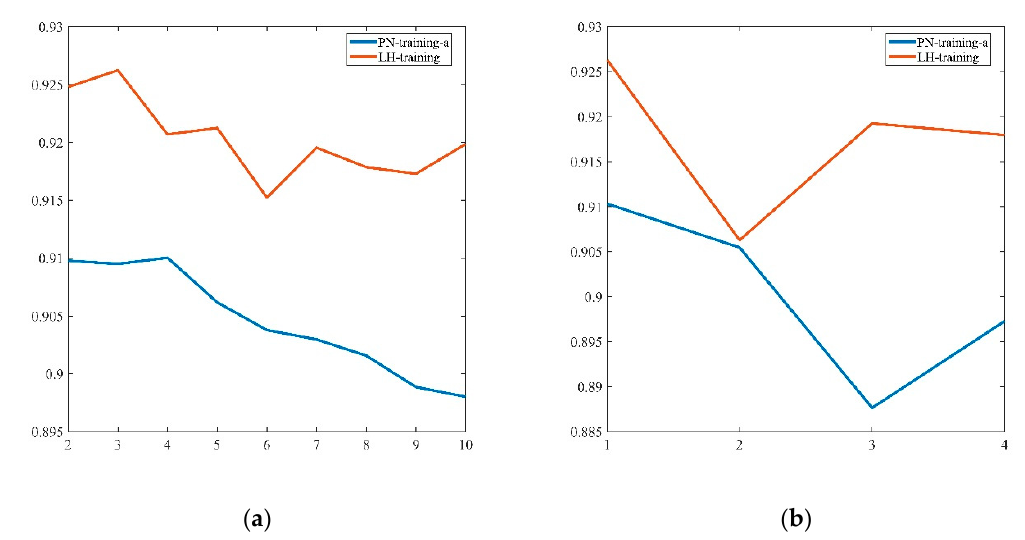
Figure 13. Accuracy of TCN classification results with different kernel sizes and stack numbers. ( a ) kernel. ( b ) stack.